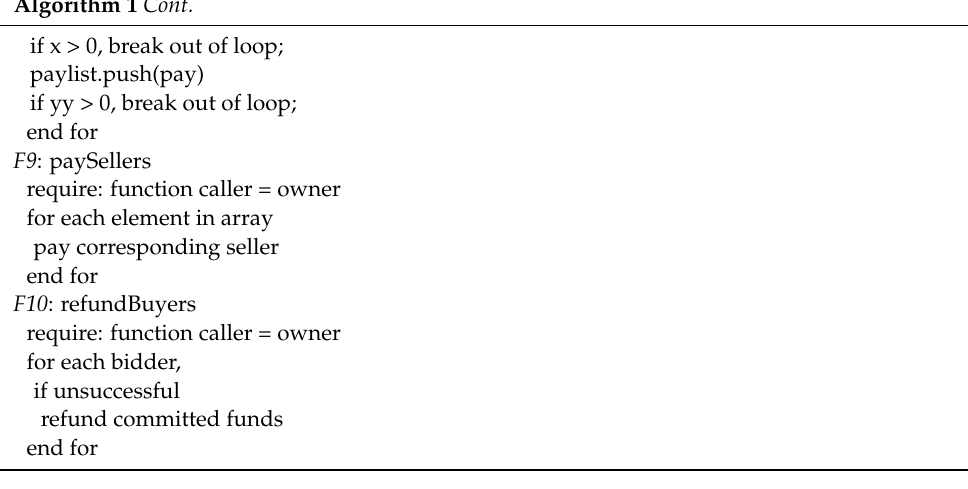
Algorithm 1 Cont.